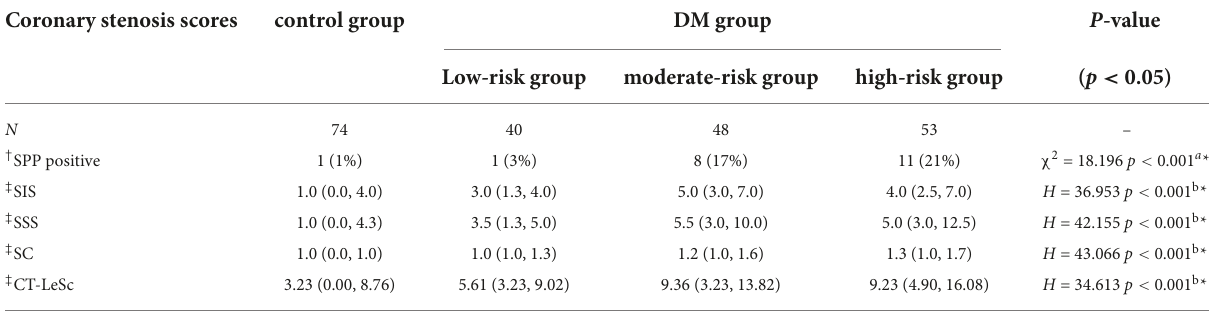
TABLE 7 Comparisons of the coronary stenosis scores among the CHD risk subgroups and the control group.